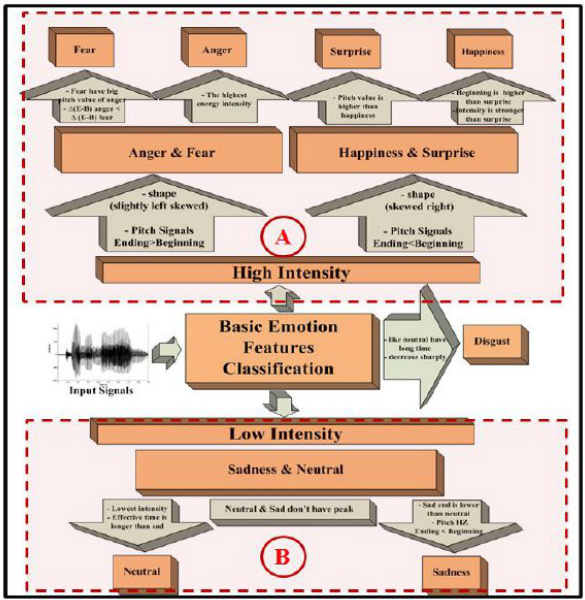
Fig. 19. Model of the system for emotion